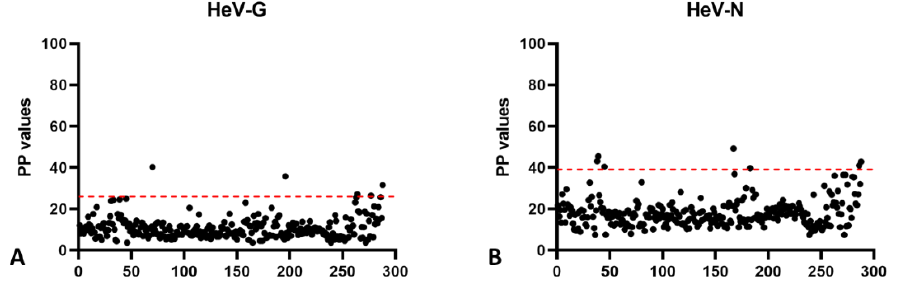
Figure 1. Testing of German negative horse populations and provisional cut-off determination. A total 288 HeV-negative German horse sera were tested in HeV-G and HeV-N ELISA, and the mean PP values plus 3 SD was set as a provisional cut-off. For HeV-G the initial cut-off PP value was determined as 26 ( A ) and for HeV-N as 39 ( B ), as shown by the red dotted lines. The provisional cut-off values were then confirmed by testing 105 HeV-negative Australian horse sera. The cut-off PP value for HeV-G was calculated as 27 (9.3 plus